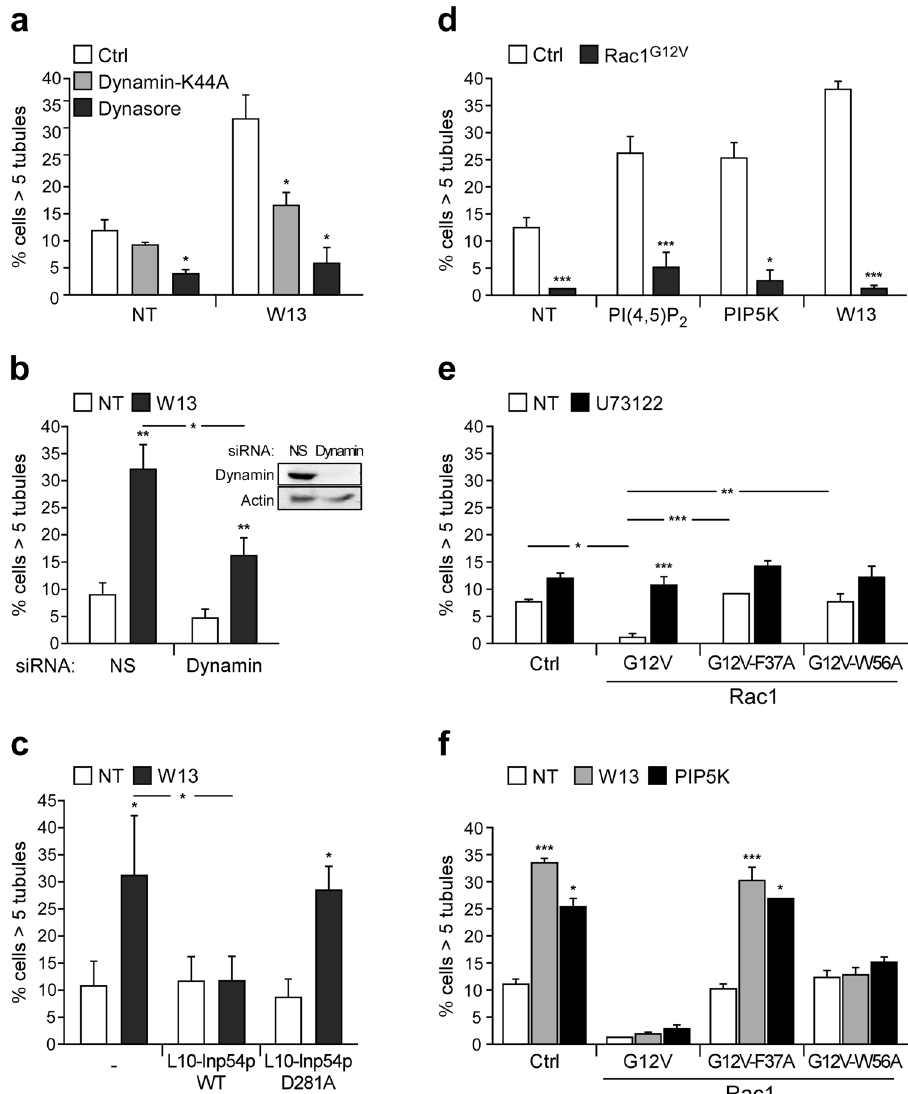
Figure 3. PI(4,5)P 2 -induced tubulation is dynamin-dependent and its inhibition by active Rac1 involves PLC activity. ( a , b ) In the presence or absence of W13 (20 min, 4.5 µ g/ml), the percentage of cells with tubules was determined after dynasore treatment (30 min, 150 µ M) or dynamin K44A expression (24 h) ( a ) and in cells transfected with a specific dynamin siRNA or a non-targeting siRNA as a control (48 h) ( b ). Downregulation of dynamin expression by its specific siRNA is shown by western blotting. ( c ) The percentage of cells with tubules was determined in cells expressing Cherry-Mem alone or co-expressed with L10-GFP Inp54p or L10-GFP Inp54p D281A , in the presence or absence of W13 (20 min, 4.5 µ g/ml). ( d ) The percentage of cells with tubules was determined in 1-hour starved cells expressing Cherry-Mem or Cherry-Rac1 G12V in the presence or absence of PI(4,5)P 2 (20 min, 50 µ M), W13 (20 min, 4.5 µ g/ml), or GFP-PIP5K expression. ( e , f ) The percentage of cells displaying tubules among the starved cells expressing GFP-mem, GFP-Rac1 G12V , or active Rac1 mutants (F37A and W56A) after the treatment with the PLC-inhibitor U73122 (20 min, 5 µ M) ( e ), W13 (20 min, 4.5 µ g/ ml), or PIP5K overexpression ( f ). Mean values ± SEM from three independent experiments are shown in all cases. Statistical significance between different conditions and the corresponding controls were determined by Student’s t -test, * p < 0.05, ** p < 0.01, *** p <